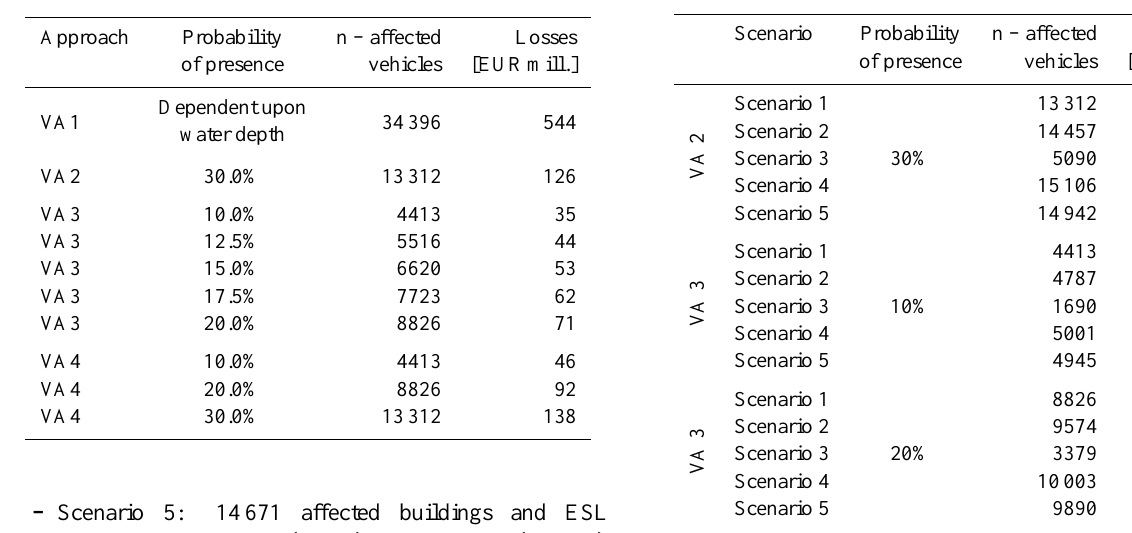
Table 5. Overview of estimated ESL to vehicles for Scenario 1, dependent upon the different approaches applied.